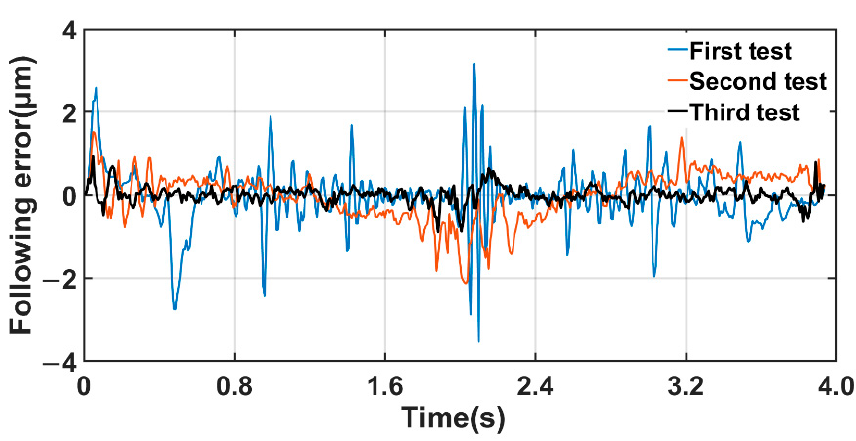
Figure 16. Following error of three processing experiments.